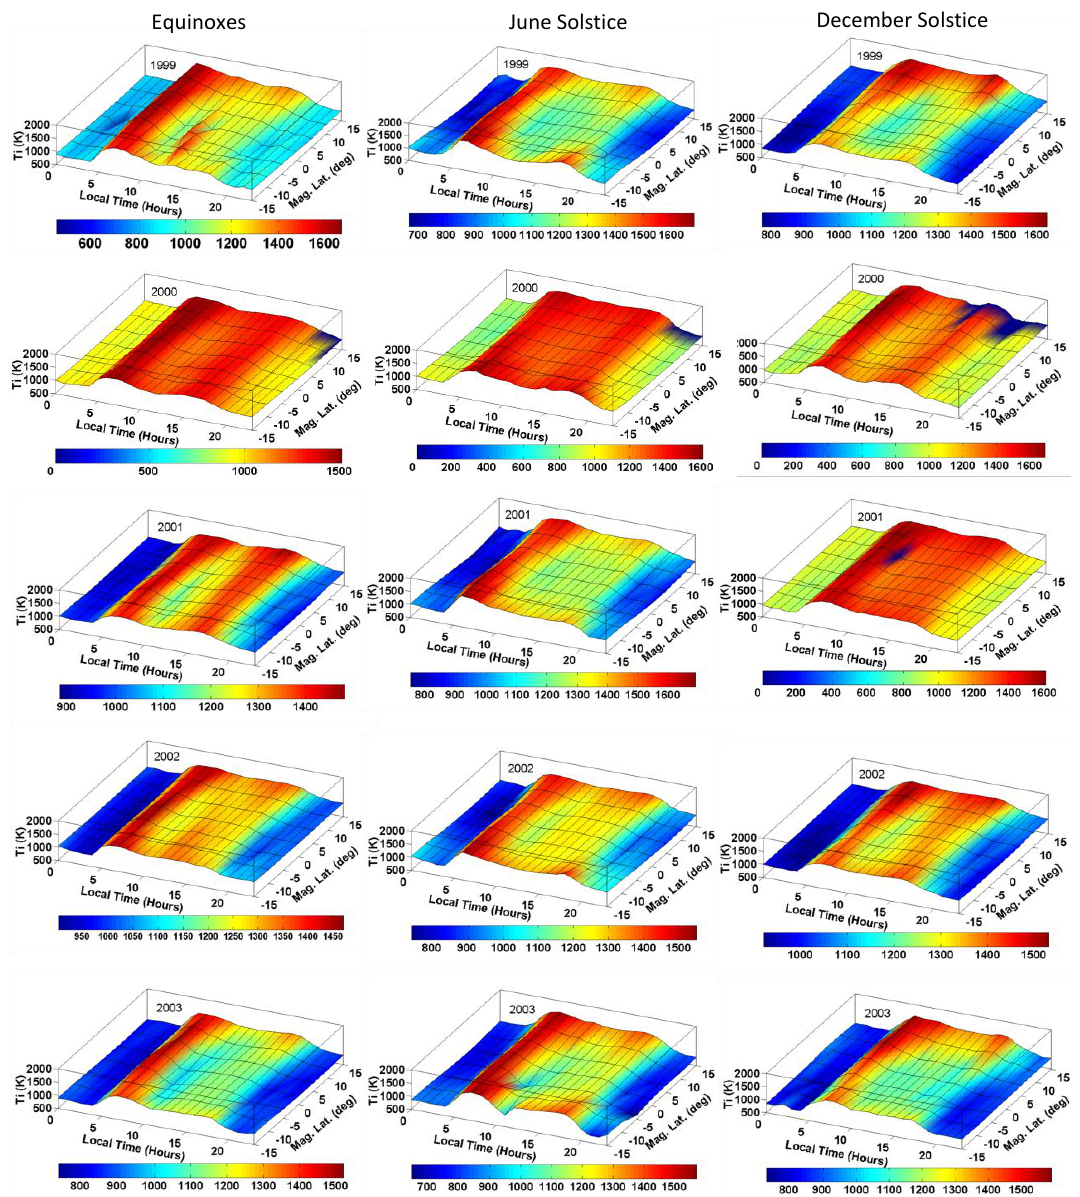
Fig. 2. Three-dimensional plots showing seasonal mean ion temperature as a function of magnetic latitude and local time measured by the ROCSAT 1 at 600km in equinox, June and December solstice (left to right) for the period 1999 to 2003 (top to